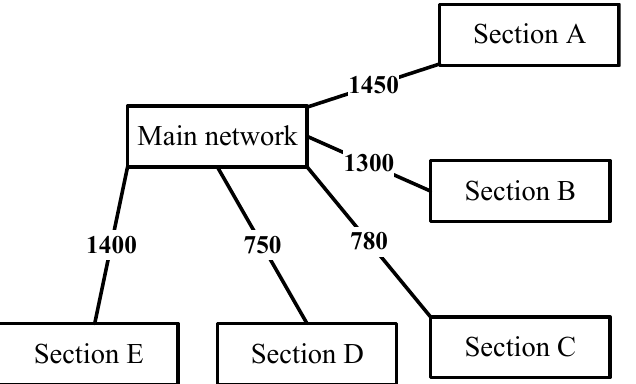
Figure 2. Model of the power grid topology and the renewable energy transmission section quota.